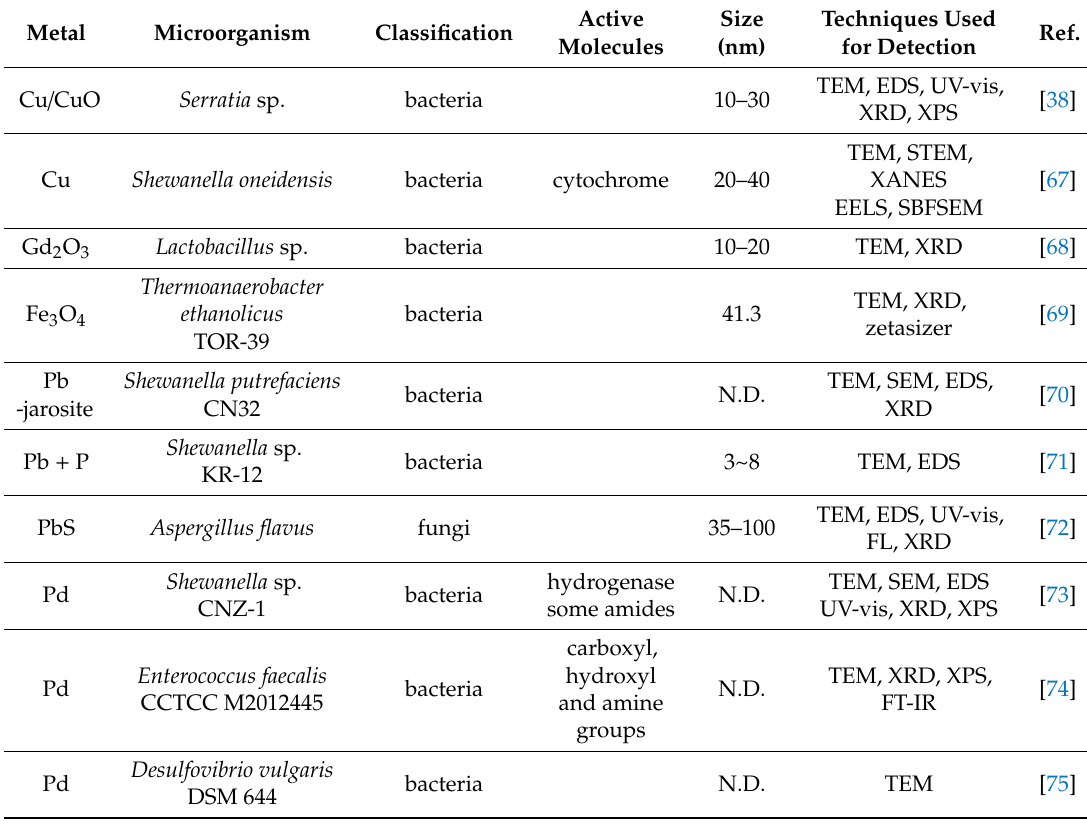
Table 5. List of microorganisms for synthesis of various metal nanoparticles and technique for confirmation of metal